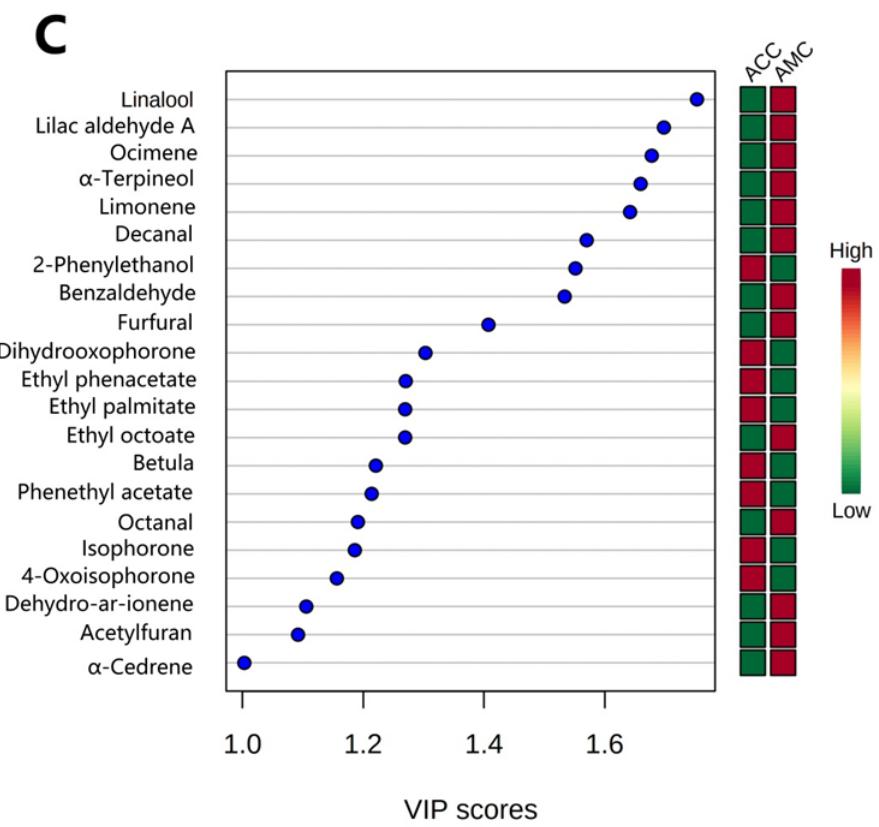
Figure 3. Discrimination of ACC and AMC. ( A ) PCA score plot of ACC and AMC; ( B ) OPLS-DA score plot of ACC and AMC; ( C ) VIP plot with VIP score > 1.